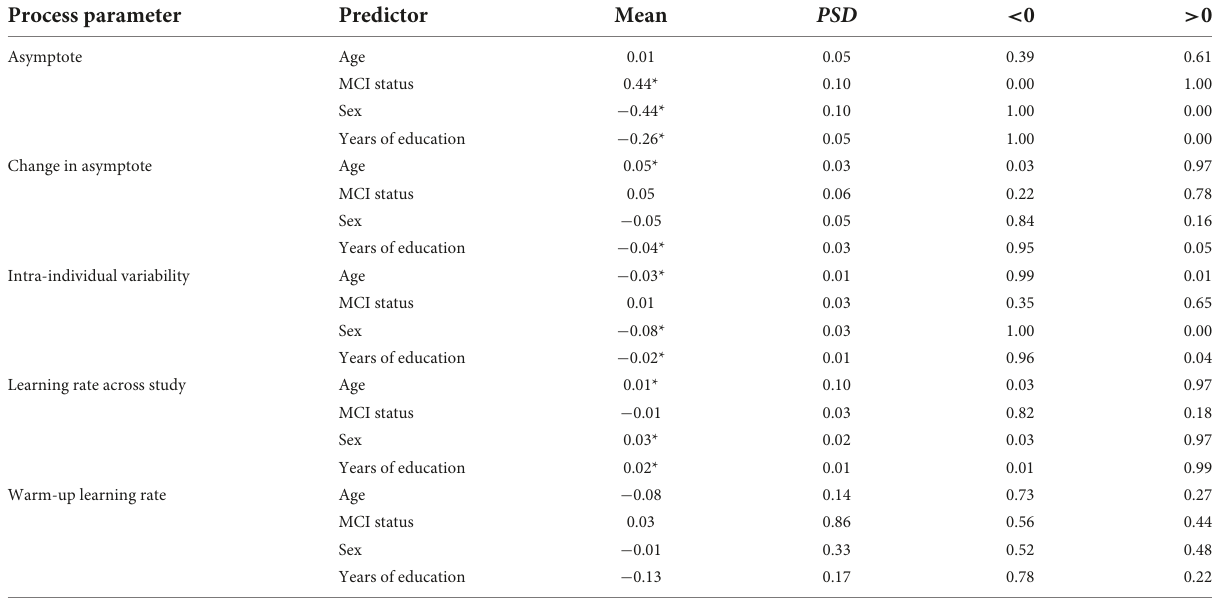
TABLE 4 Summary of links between cognitive performance characteristics of grid memory task and selected explanatory variables. Process